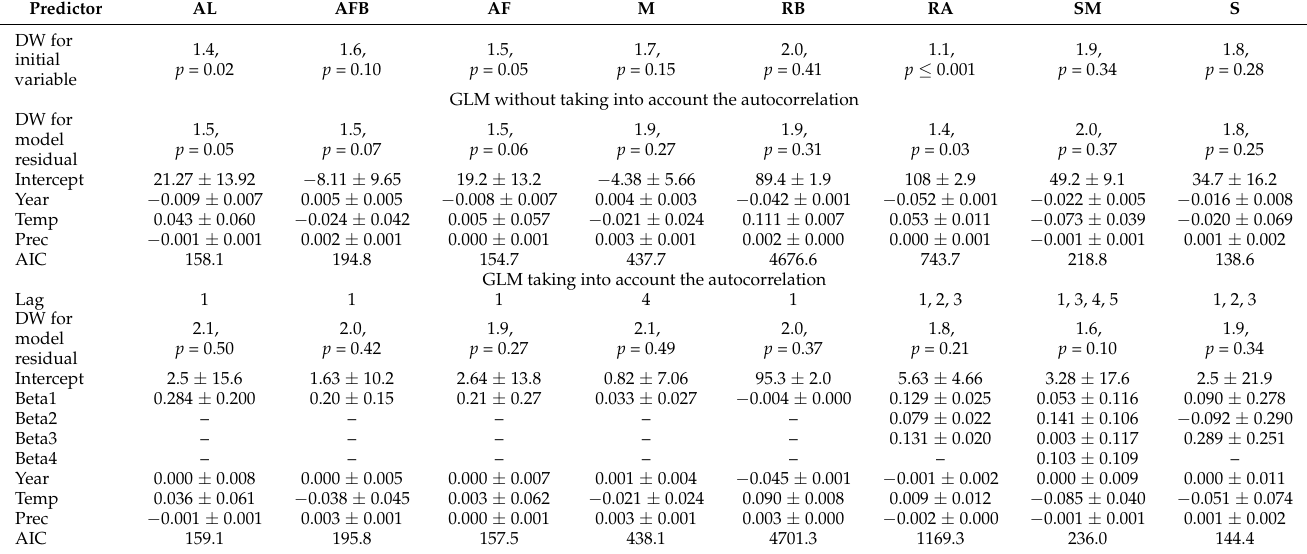
Table 3. Generalized linear models of the time and biotope type effect on the bird community abundance and Durbin–Watson test (DW) for time series and model residuals. Beta 1, 2, or 3